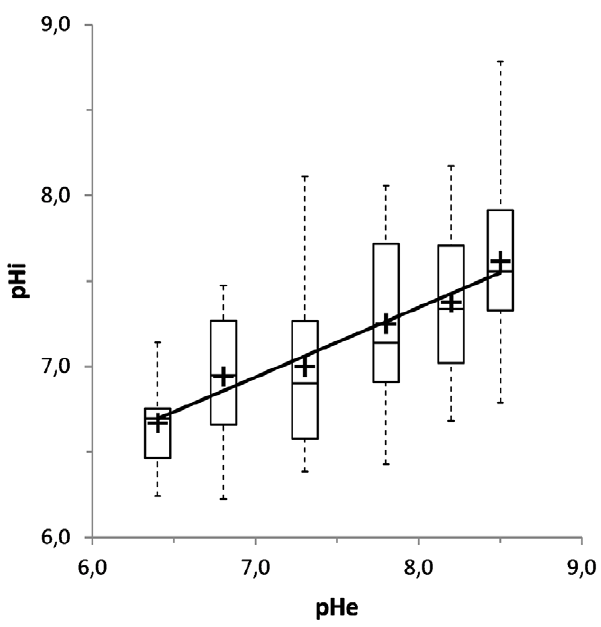
Figure 2. Influence of external pH on intracellular pH. Thalassiosira weissflogii cells were loaded with BCECF-AM at different external pH values (pHe). Ratiometric emission (with excitation at 485 and 436 nm) was used to calculate intracellular pH values (pHi). The relation between pHe and pHi measurements was fitted to a linear regression ( r 2 = 0.306; Fisher’s, p , 0.0001), and corresponds